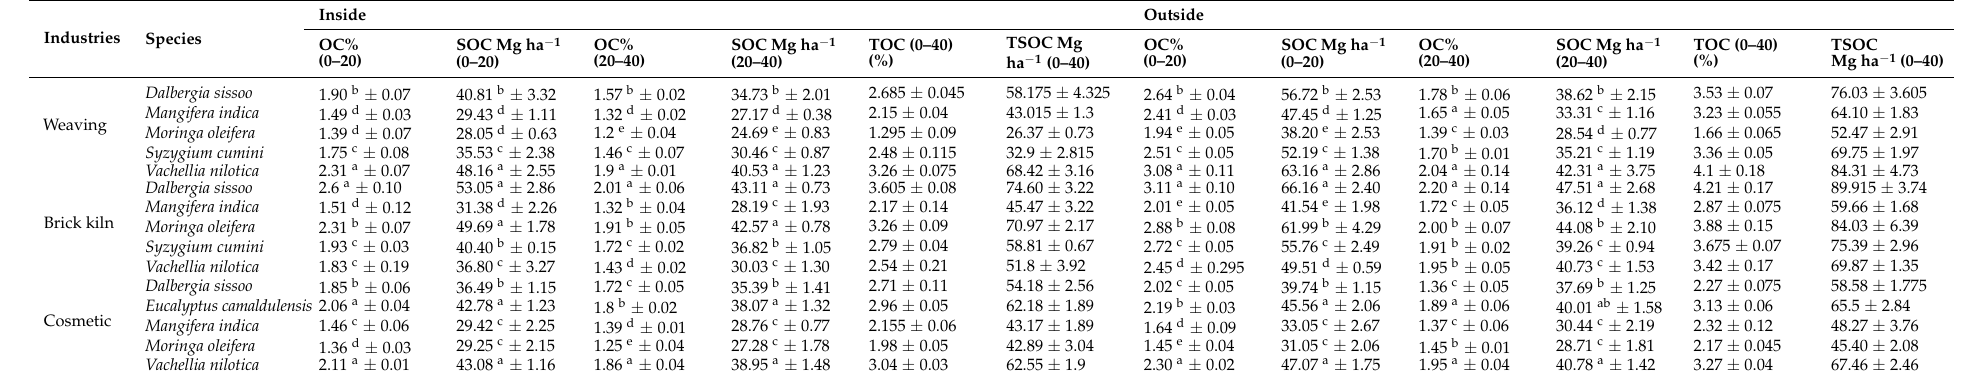
Table 6. Soil organic carbon of different tree species present inside and outside the different industries. Where first and second values represent the mean values and standard deviation. Moreover, OC (organic carbon) and SOC (soil organic carbon) represent organic carbon and soil organic